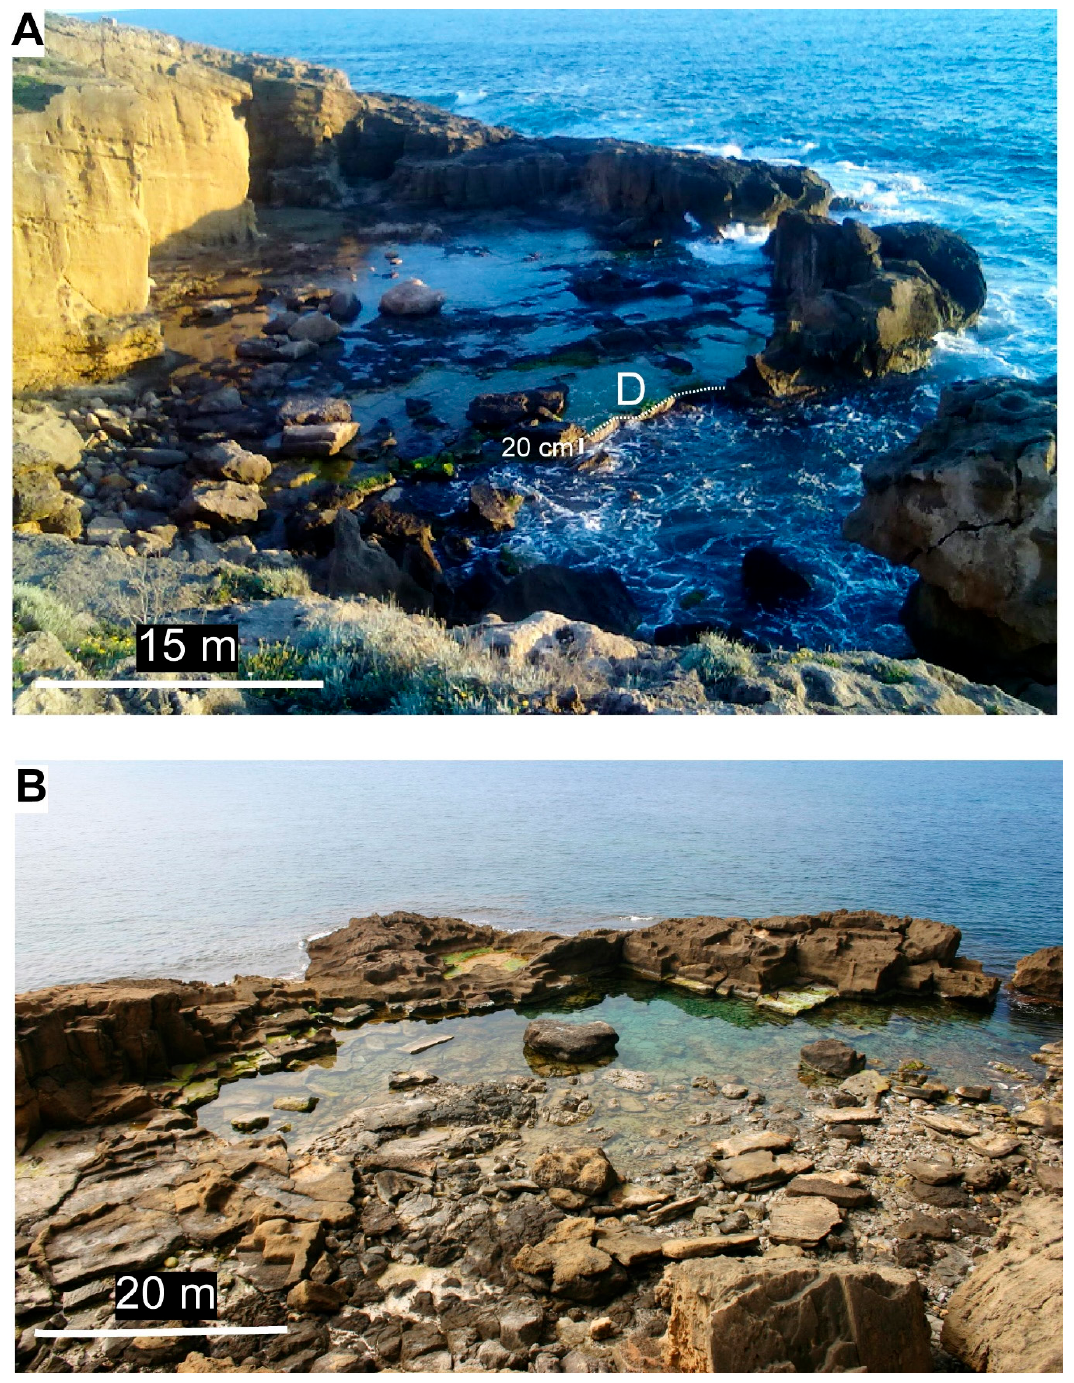
Figure 15. Zio Peppino quarry general view. A ) Left side of the quarry flooded during major storms. With D indicated the 19th Century dock 20 cm above the present mean sea level. B ) The right part (north side) permanently submerged. The maximum water high during springtime low tide is 30